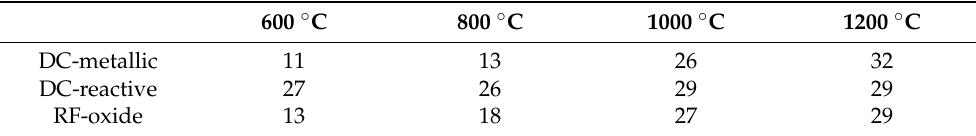
Table 2. Calculated grain size in nm using the Scherrer equation and the (111) reflection.